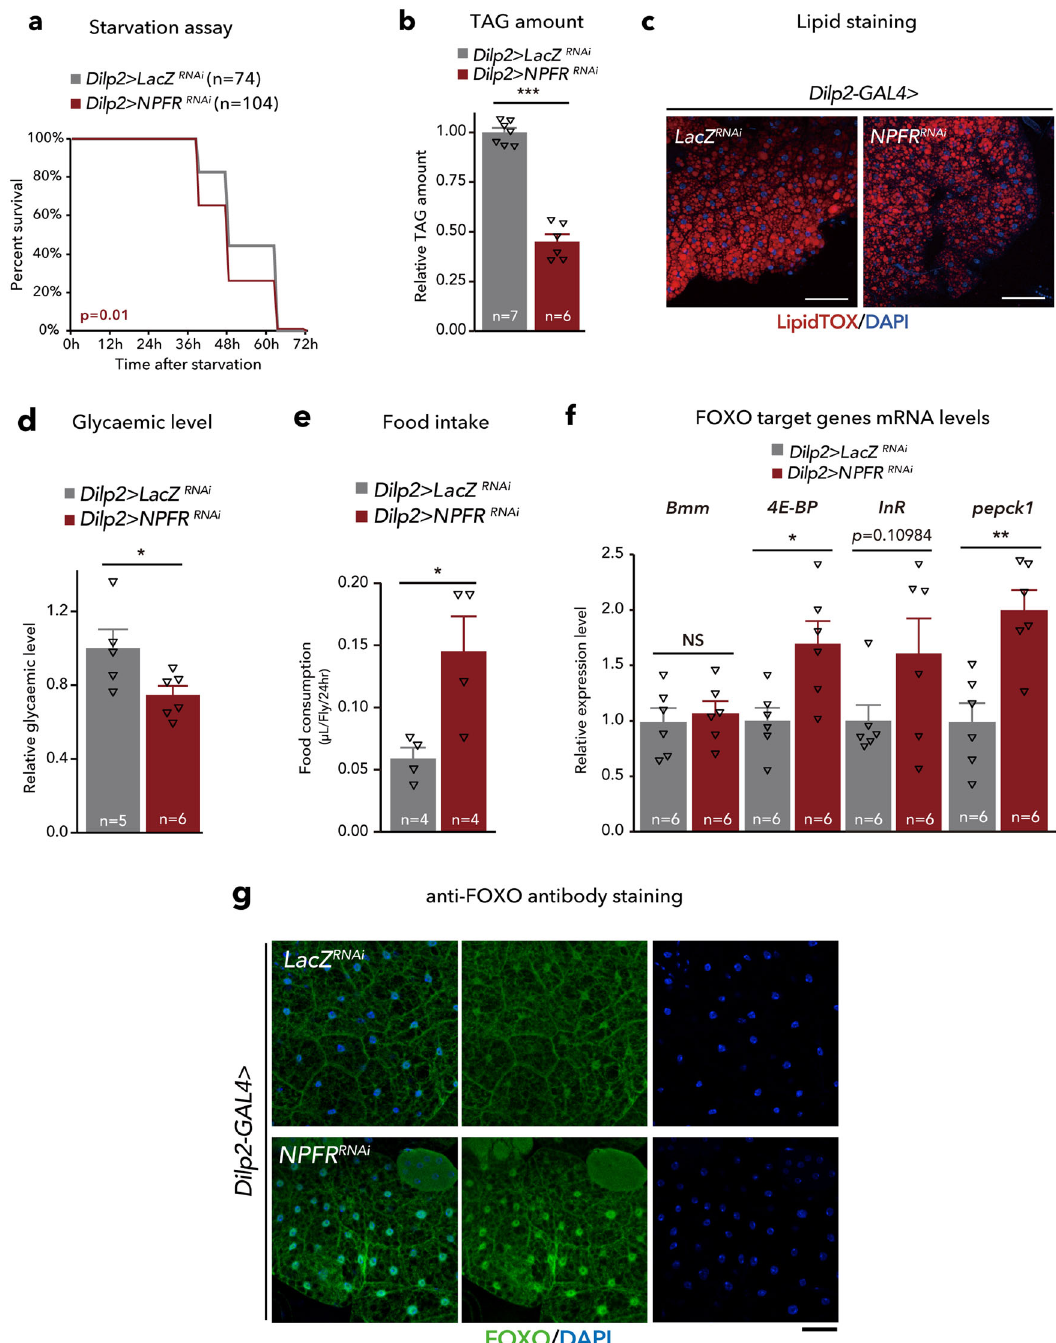
Fig. 8 NPFR in the insulin-producing cells regulates carbohydrate/lipid metabolism. a Survival during starvation in fl ies of each genotype. The number of animals assessed ( n ) is indicated in the graphs. b Relative whole-body TAG levels of each genotype. The number of animals assessed ( n ) is indicated in the graphs. c LipidTOX (red) and DAPI (blue) staining of dissected fat body tissue from indicated genotypes. Scale bar, 20 µ m. d Relative glycaemic levels in control and Dilp2>NPFR RNAi . The number of samples assessed ( n ) is indicated in the graphs. e Feeding amount measurement of each genotype with CAFÉ assay. n = 4 samples, each point contained four adult female fl ies. f RT-qPCR analysis of FOXO-target gene mRNA levels in the fat body dissected from each genotype. The number of samples assessed ( n ) is indicated in the graphs. g FOXO (white) immunostaining of the fat body in adult fl ies of each genotype. Scale bar, 50 µ m. For RNAi experiments, LacZ knockdown ( Dilp2>LacZ RNAi ) was used as negative control. For all bar graphs, mean and SEM with all data points are shown. For dot blots, the three horizontal lines indicate lower, median, and upper quartiles. Statistics: Log rank test ( a ), two-tailed Student ’ s t -test ( b , d – f ). * p < 0.05, ** p < 0.01, *** p < 0.001; NS, non-signi fi cant ( p > 0.05). p -values: a , p = 0.0100; b p < 0.0001; d p = 0.0417; e p = 0.0269; f p = 0.6468 ( Bmm ), p = 0.0146 ( Thor ), p = 0.1098 ( InR ), p = 0.0024 ( pepck1